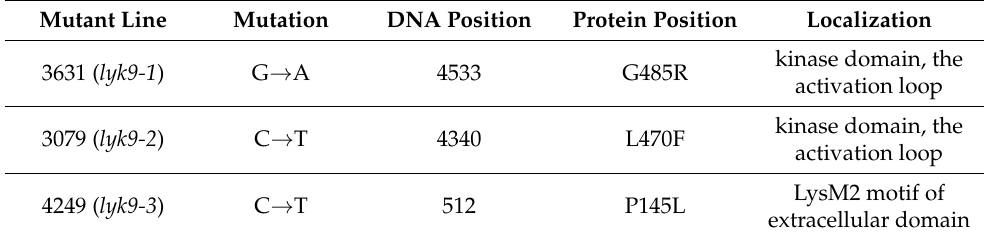
Table 1. Mutations in the lyk9 gene and their effect in mutant plants. Mutant